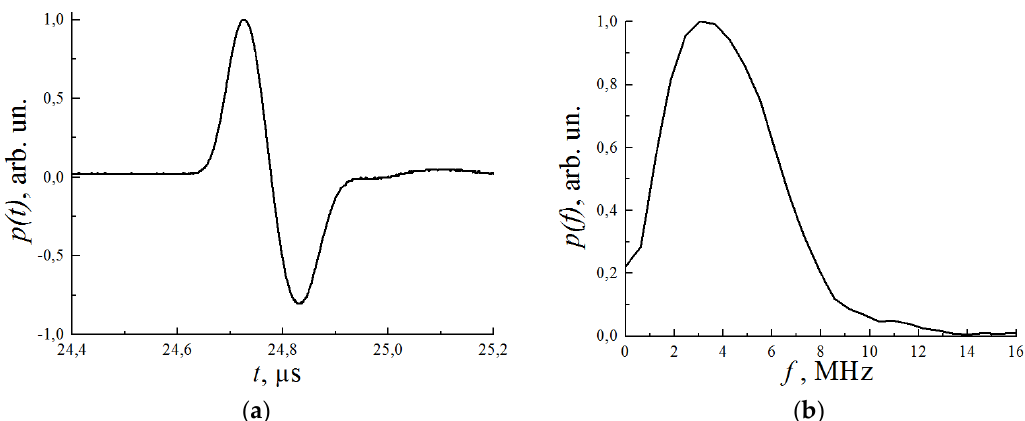
Figure 1. Specific temporal shape ( a ) and spectrum ( b ) of laser-induced photoacoustic (PA) pulse. Reproduced with permission from [41], Springer Nature, 2009.